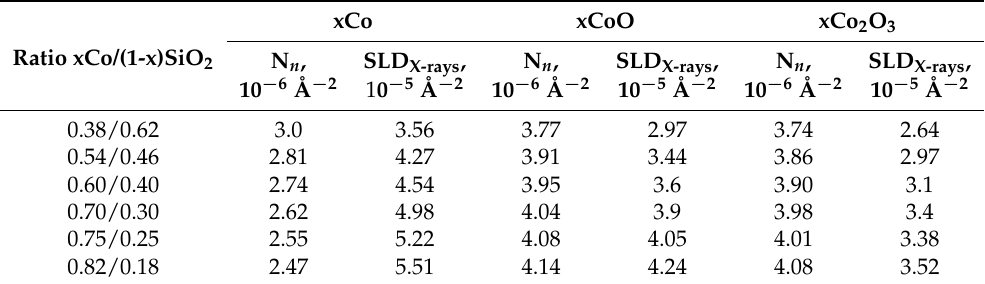
Table 4. The calculated N n and SLD X-rays values for a given ratio of Co/SiO 2 in GF under the assumption that cobalt can be oxidized.